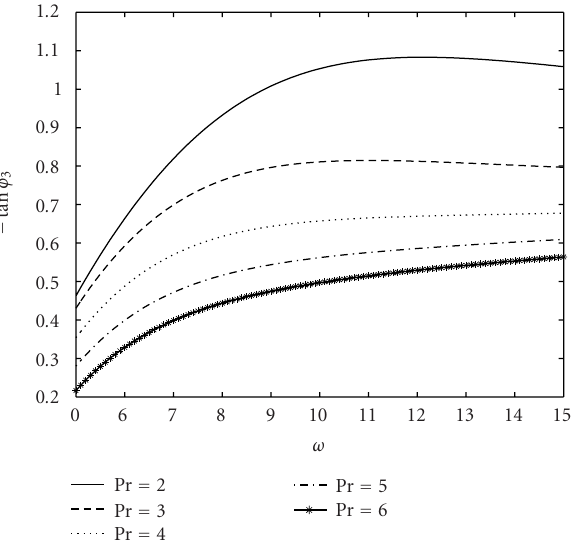
Figure 4.12. Tangent of phase shift of the rate of heat transfer for Gr = 5 . 0, S = 1 .